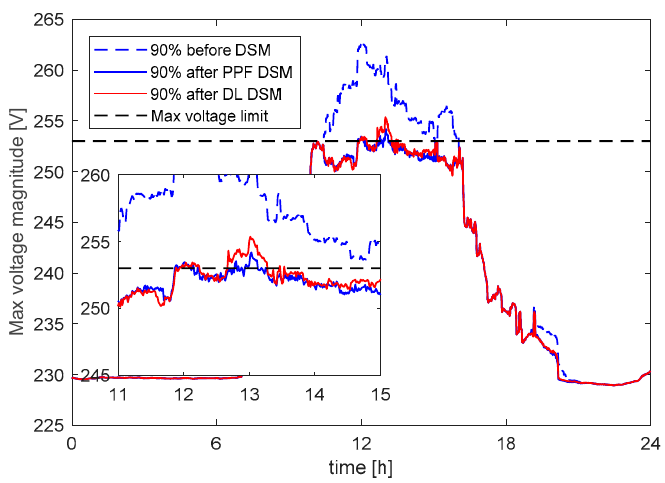
Figure 8. 90% probability maximum voltage magnitudes over time.